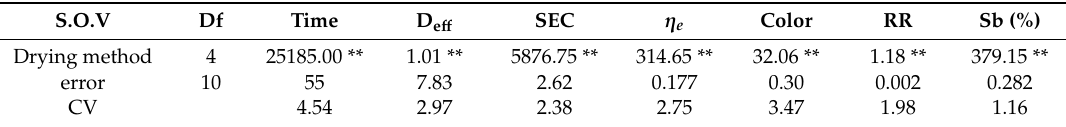
Table 4. Analysis of variance (ANOVA) for the e ff ect of drying methods on drying time, e ff ective di ff usivity ( D e ff ), specific energy consumption ( SEC ), color, rehydration ratio ( RR ), and shrinkage (S b ) of